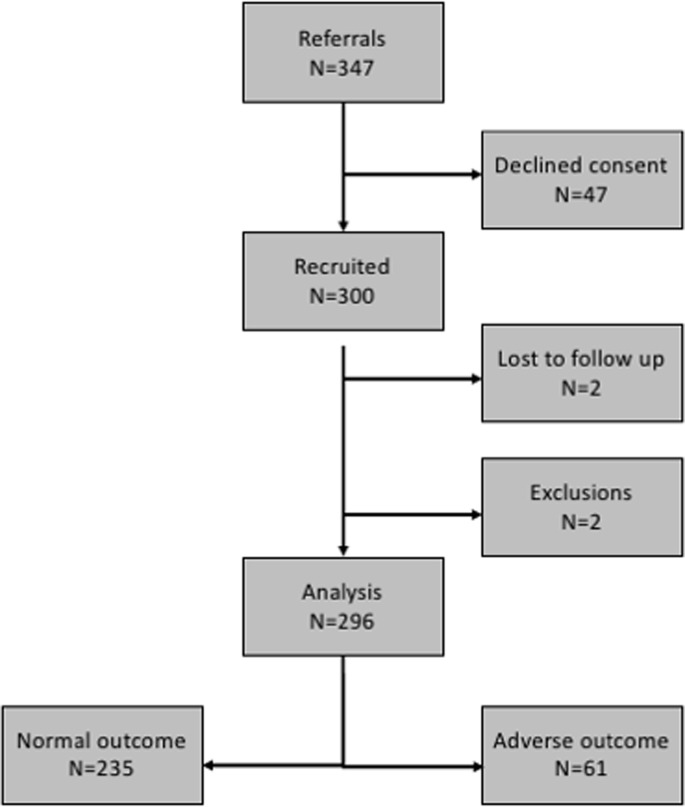
Flow of participants through the FEMINA2 study.